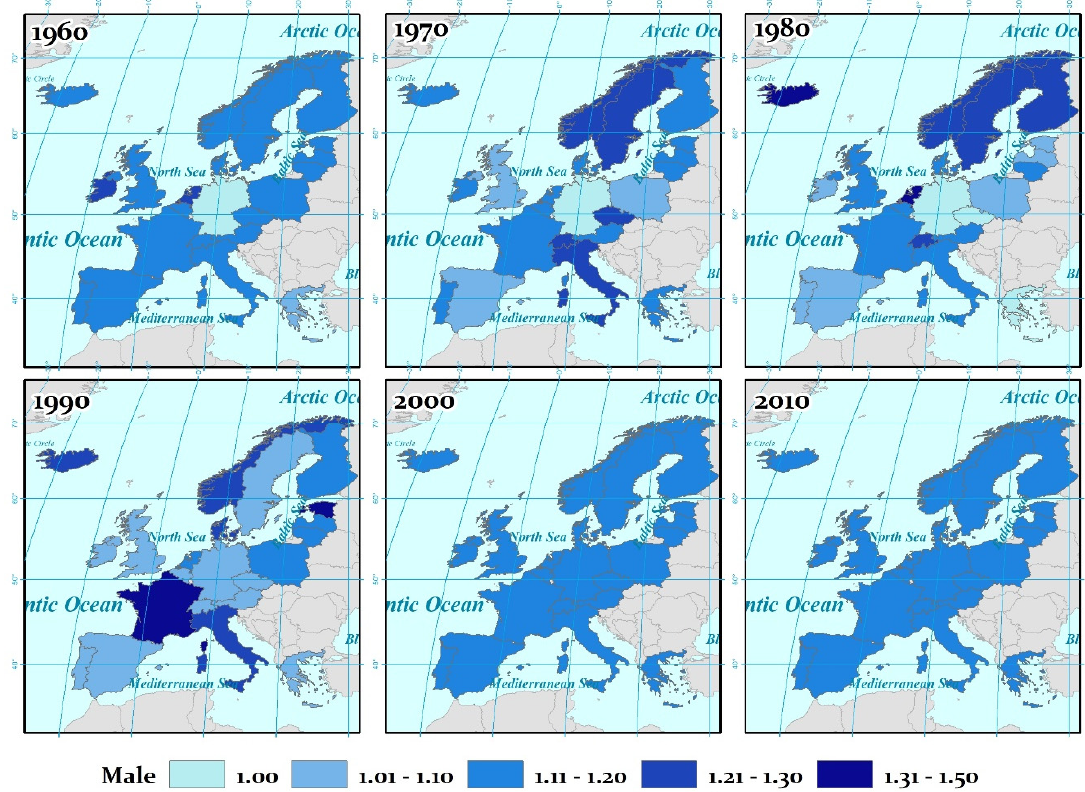
Figure 2. The evolution of random risk factor for the 22 EU countries (parameter λ —male).